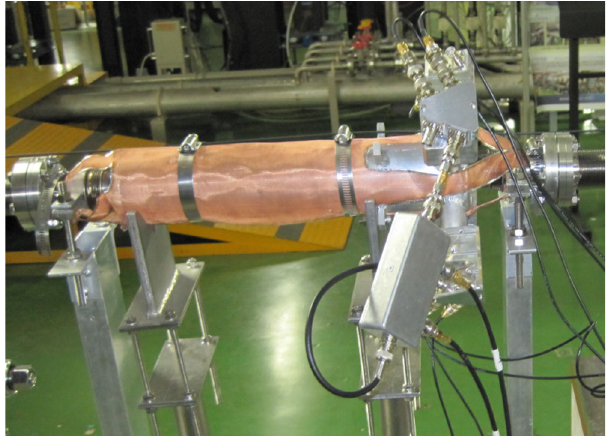
FIG. 12. Photograph of the kicker K2 in the ATF beam line.